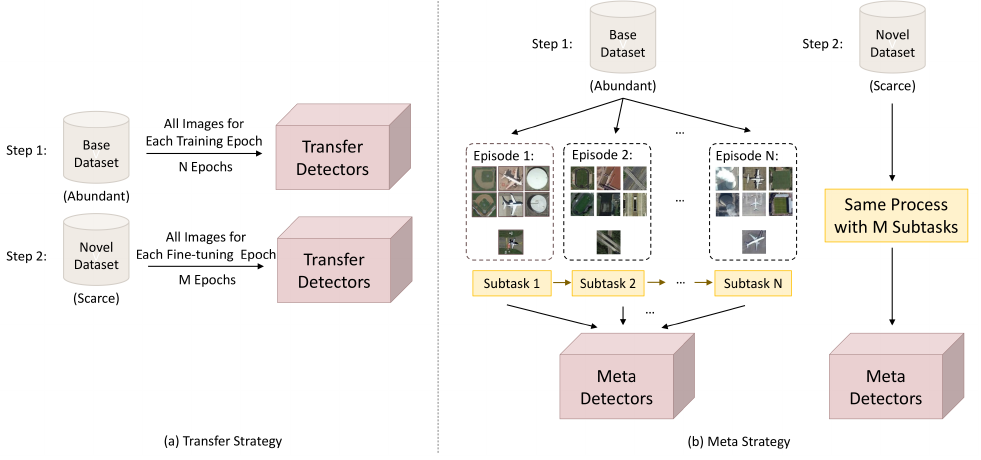
Figure 15. The difference between ( a ) transfer strategy and ( b ) meta